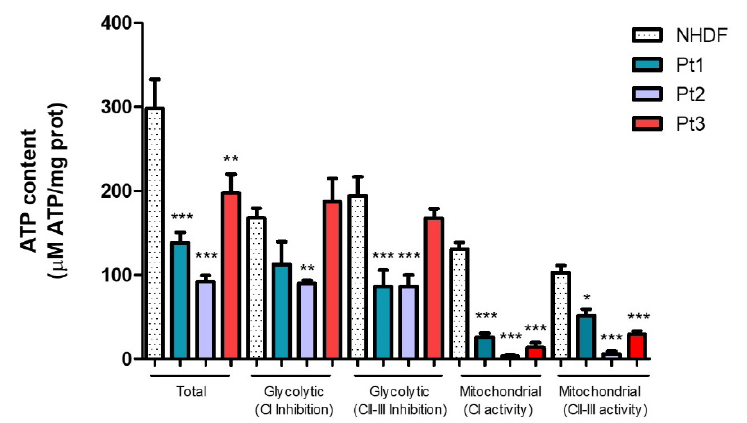
Figure 6. ATP production in NHDF and PD patients. Total, glycolytic and mitochondrial ATP levels, expressed as μM ATP/mg protein (prot), were assayed. All data represent the means of at least 3 replicates ± standard deviation. The analysis of variance was carried out using the One-way ANOVA test followed by the Tukey’s Multiple Comparison Test; * p < 0.05, ** p < 0.01, *** p < 0.001 were considered significant (patients vs. NHDF). Pt1: patient 1; Pt2: patient 2; Pt3: patient 3; NHDF: normal human dermal fibroblast; CI: Complex I; CII-III: Complex II-III. As shown in Figure 7a, SE did not have any effects on the ATP production in NHDF.